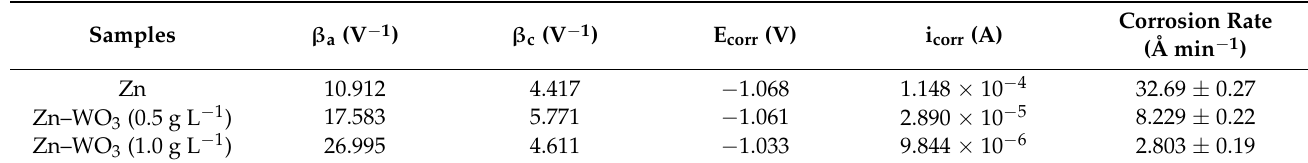
Table 2. Electrochemical coating parameters extrapolated from Tafel